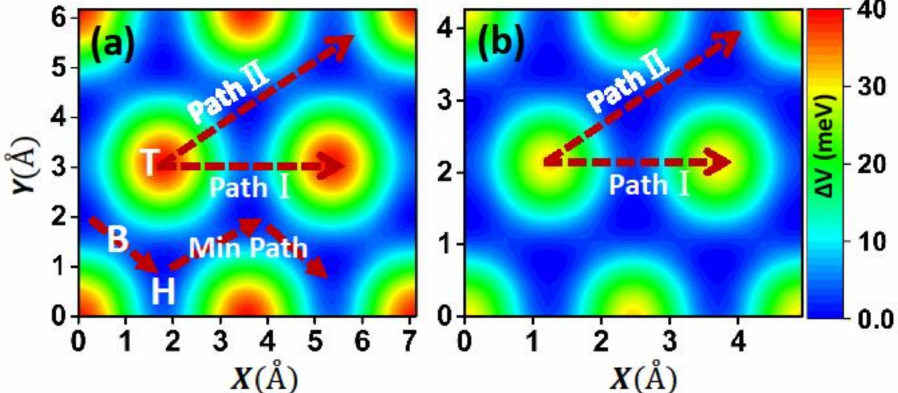
Figure 3. Potential energy surface (PES) for the ( a ) Ca2N and ( b ) graphene systems. T, B, H are the top, bridge, and hollow sites indicated in Figure 1. We also show the two chosen paths and the minimum energy sliding